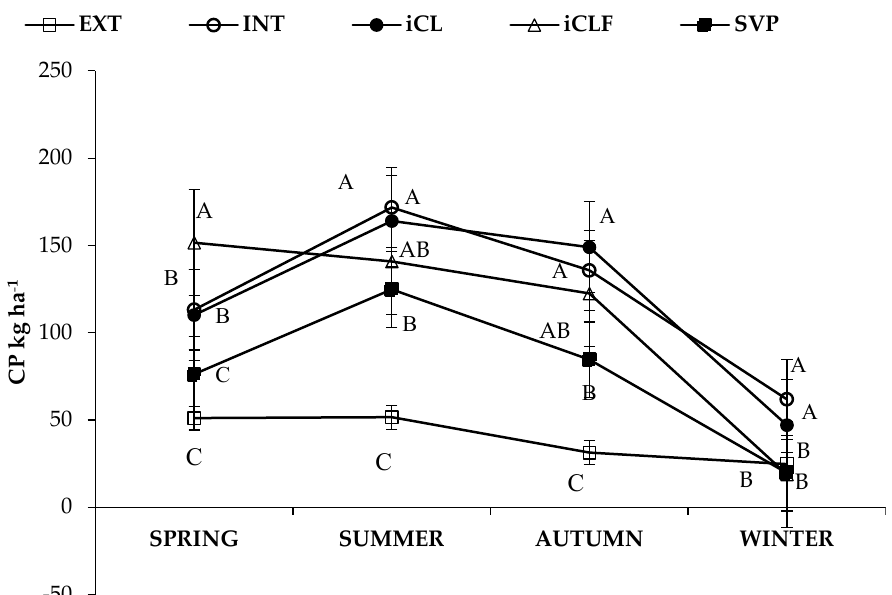
Figure A2. In vitro digestibility (kg ha − 1 ) during seasons from different livestock production systems (means of two years). Different letters in the same season differ from each other ( p < 0.05) according to the Tukey test. EXT: extensive; INT: intensive; iCL: integrated crop–livestock; iCLF: integrated crop–livestock–forest; iLF: integrated livestock–forest.